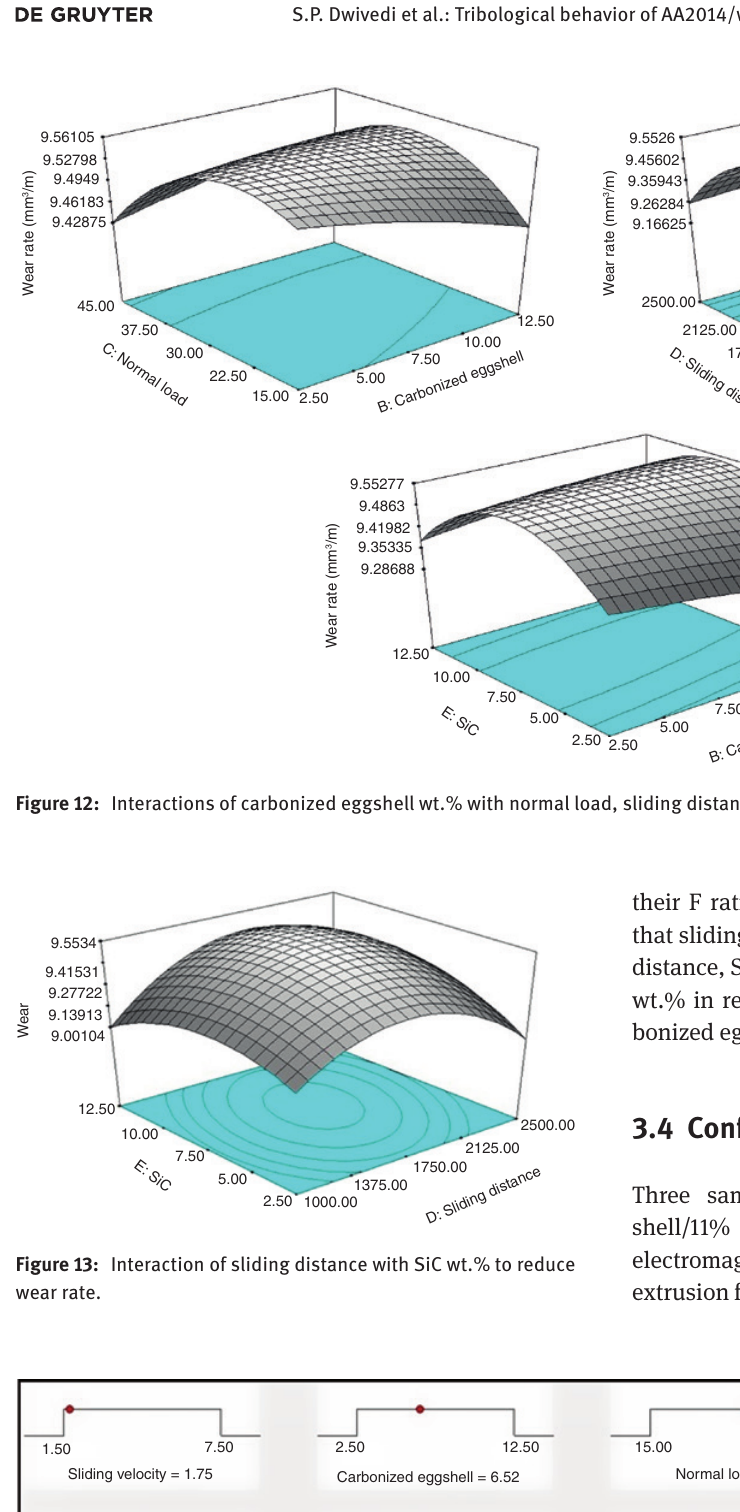
Figure 14: Ramp function graph for the minimum wear rate with desirability one.